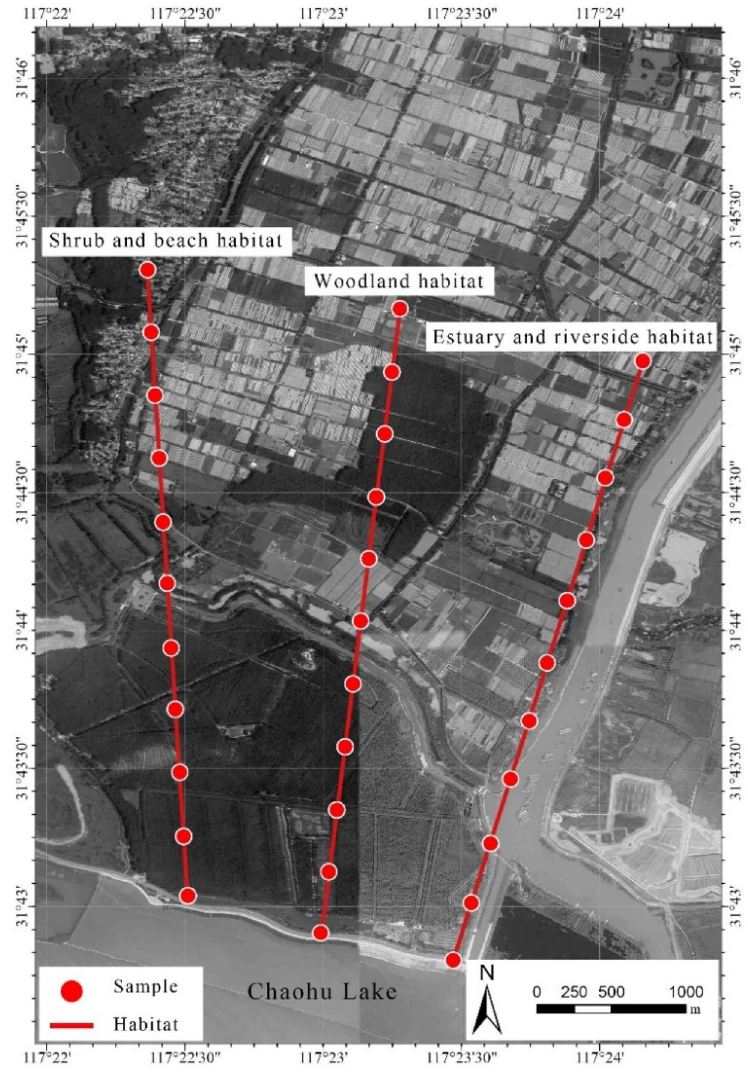
Figure 1. Location and distribution of sampling points in the Lake Chaohu wetland. Figure created with WeMap Version 3.9.1. http:// www. river map. cn/ index.